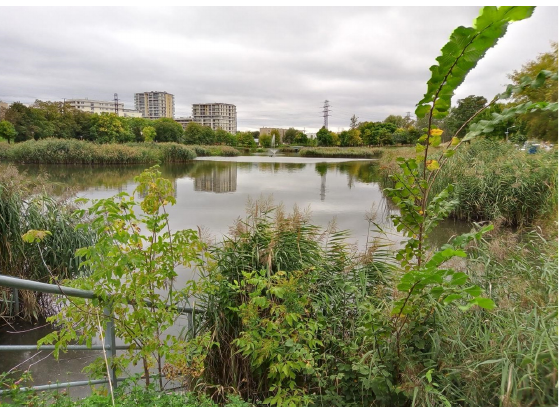
Figure A13. S ł u ż ewiecki pond—flow-through basin at the intersection of Pu ł awska and Rzymowskiego streets (source: own).